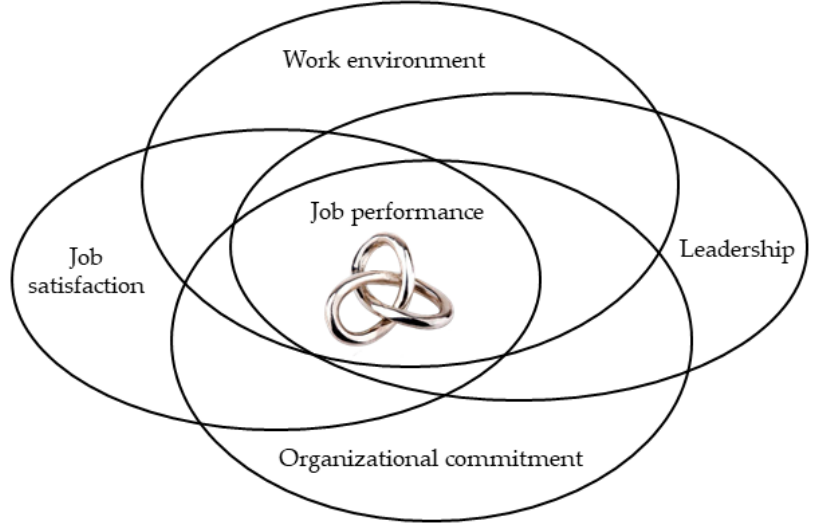
Figure 1. Conceptual model of job performance.